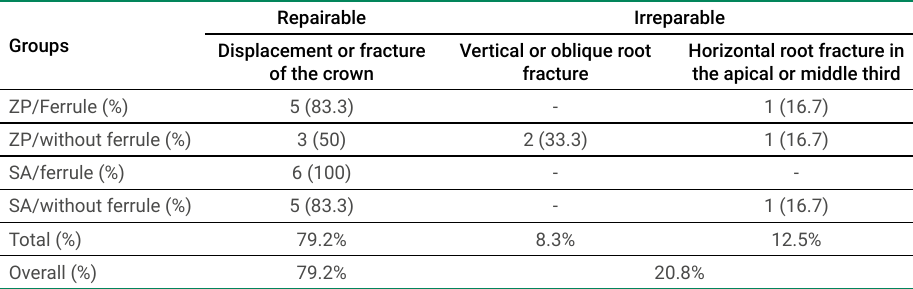
Table 2. Fracture modes and overall percentage of repairable and irreparable for the experimental groups (n=6) Groups Displacement or fracture Vertical or oblique root Horizontal root fracture in of the crown fracture the apical or middle